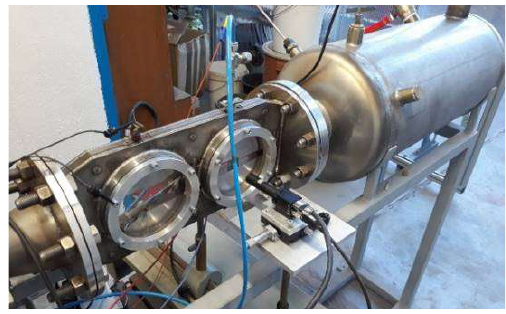
Fig. 1. The wind tunnel .